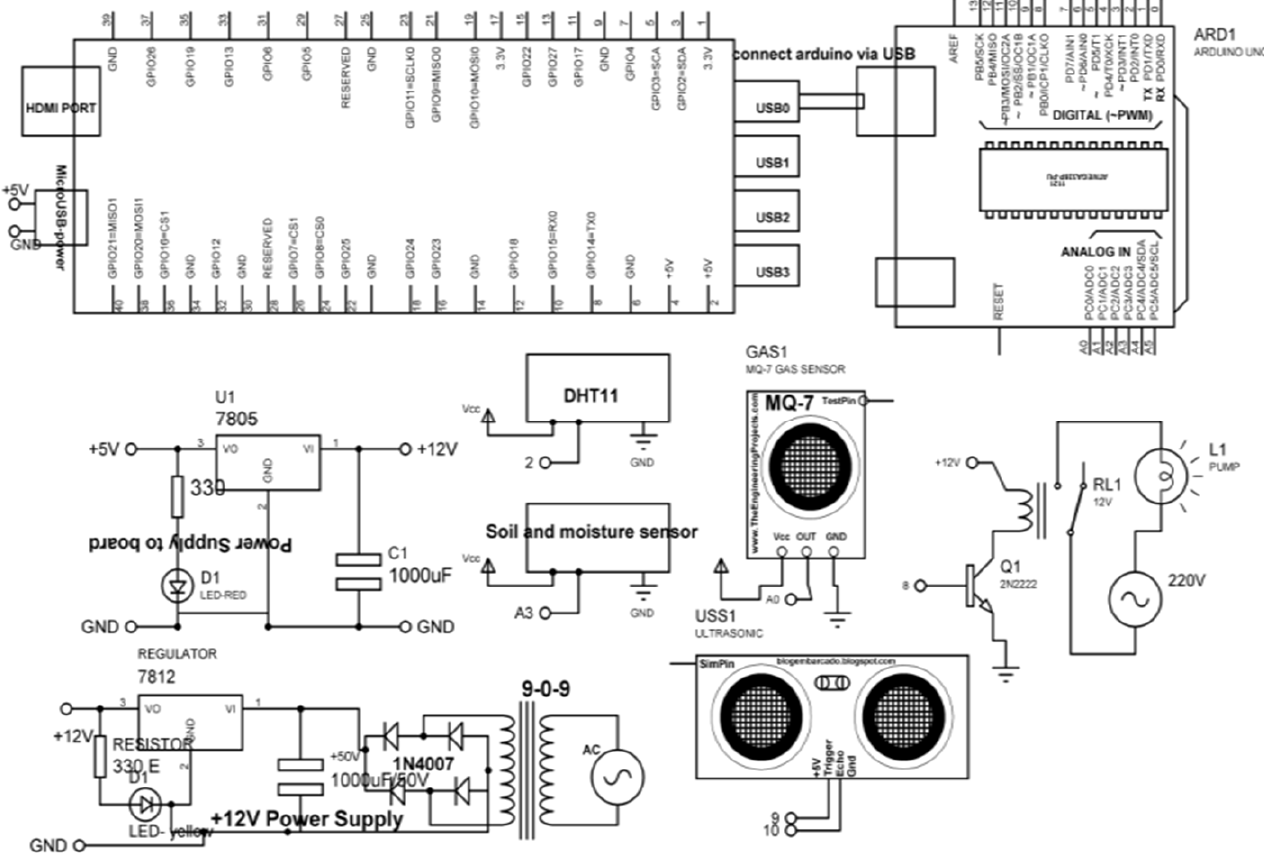
Figure 5. Circuit diagram of the sensor node.